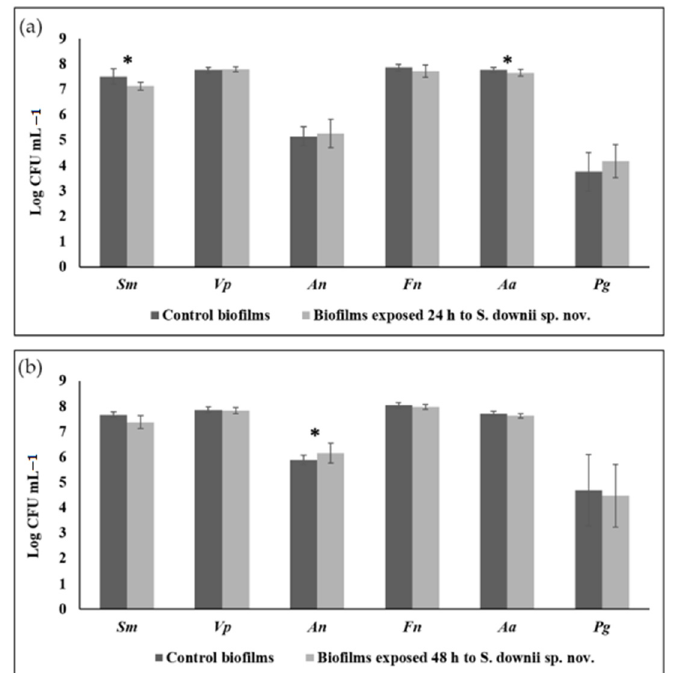
Figure 7. Counts (expressed as logarithm of colony forming units per mL, CFU/mL) of Streptococ-